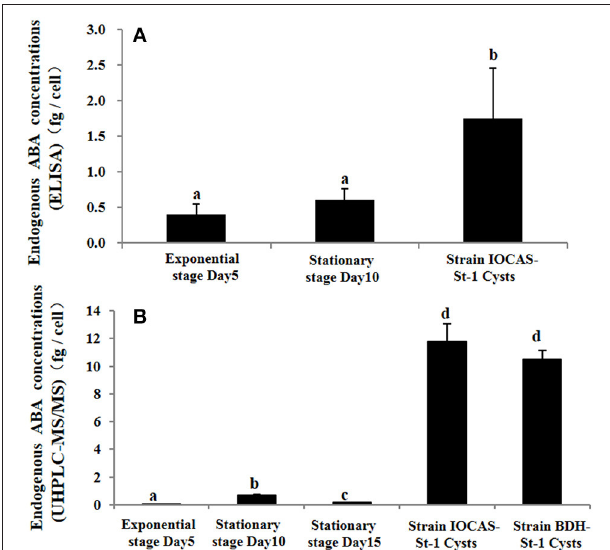
FIGURE 5 | Endogenous ABA concentrations in vegetative cells (at exponential and stationary growth stages) and resting cysts of S. trochoidea via (A) ELISA and (B) UHPLC-MS/MS quantification. Growth stages of strain IOCAS-St-1 were determined according to the growth curve (Supporting information Methods S2). The Y axis shows the expression levels of targeted genes relative to the reference gene; Significant differences are denoted with different letters above bars at p < 0.05; same letter denotes no significant difference. Values are presented as mean ± standard deviation, Error Bars = SD, n =